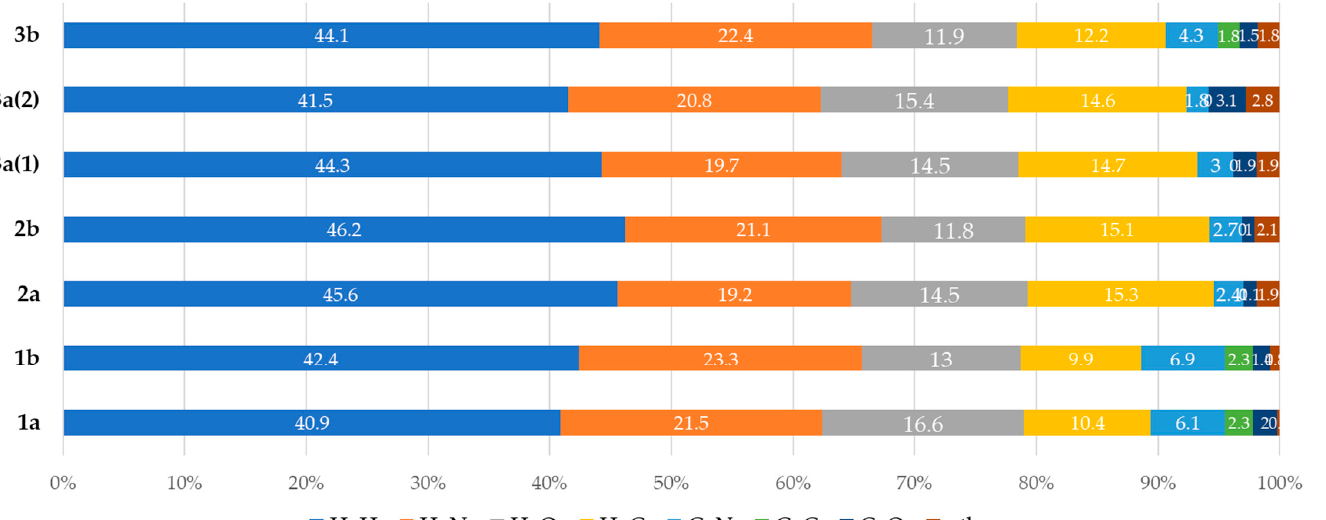
Molecules 2021 , 26 , x FOR PEER REVIEW Figure 2. Contributions of various intermolecular contacts to the molecular Hirshfeld surfaces of ( 1 – 3 ) a , b .